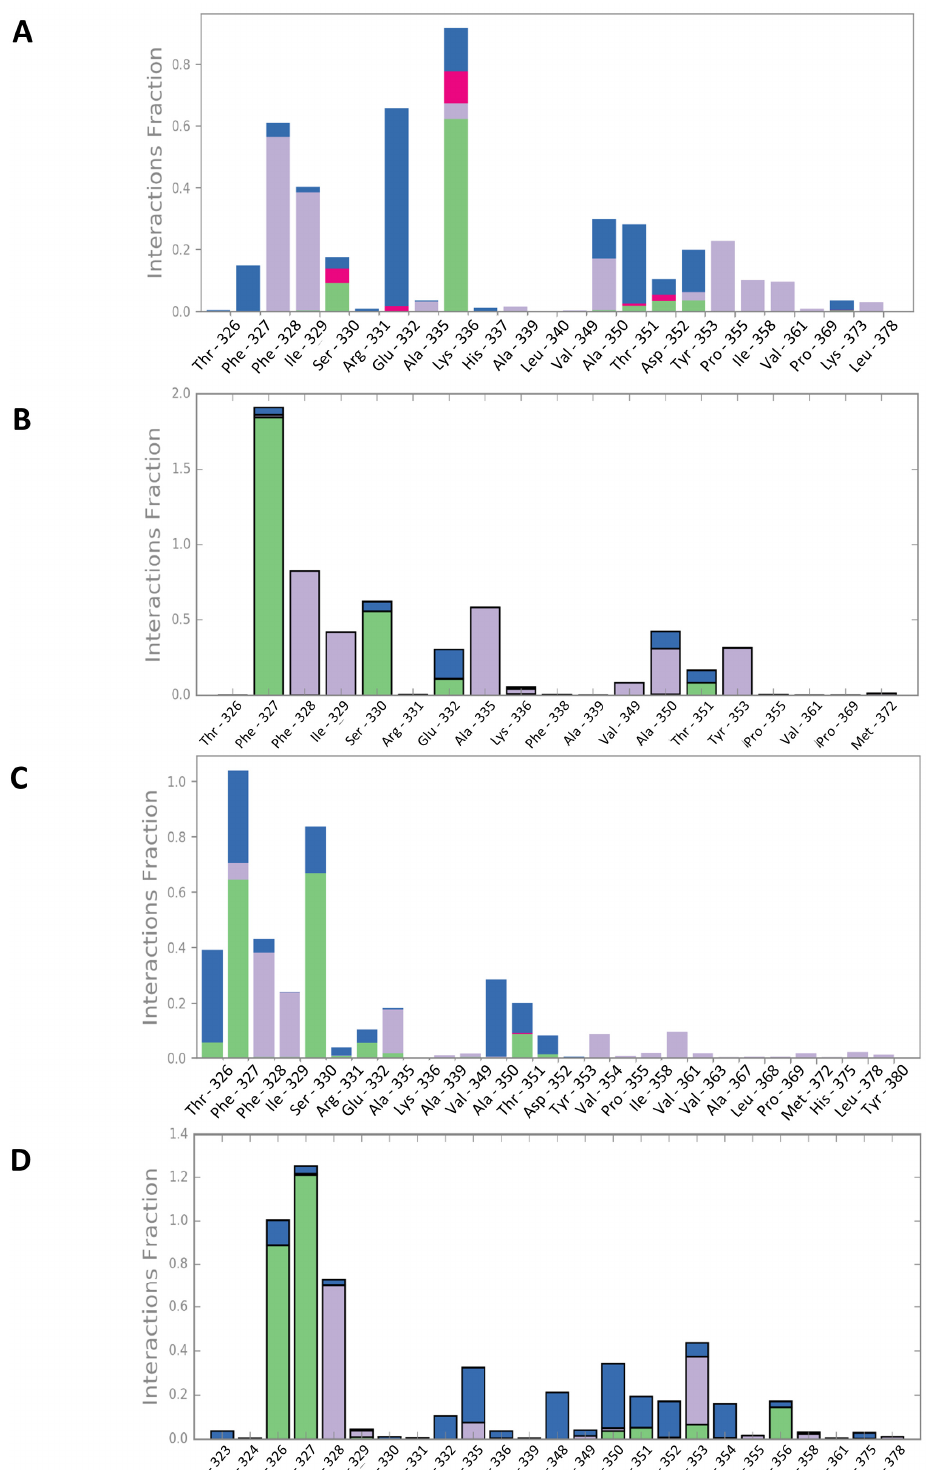
Figure 5. Persistence of the model–ligand interactions found within the constructed Lmj_04_BRCT models and selected compounds during the 50 ns molecular dynamics simulation. ( A ) CPE1-Mult1_lr, ( B ) CPE2-Mult1_lr, ( C ) CPE3-Mult1_lr, ( D ) CPE4-Mult1_lr. Green: hydrogen bonds. Purple: hydrophobic interactions. Red: ionic interactions. Blue: water bridges.